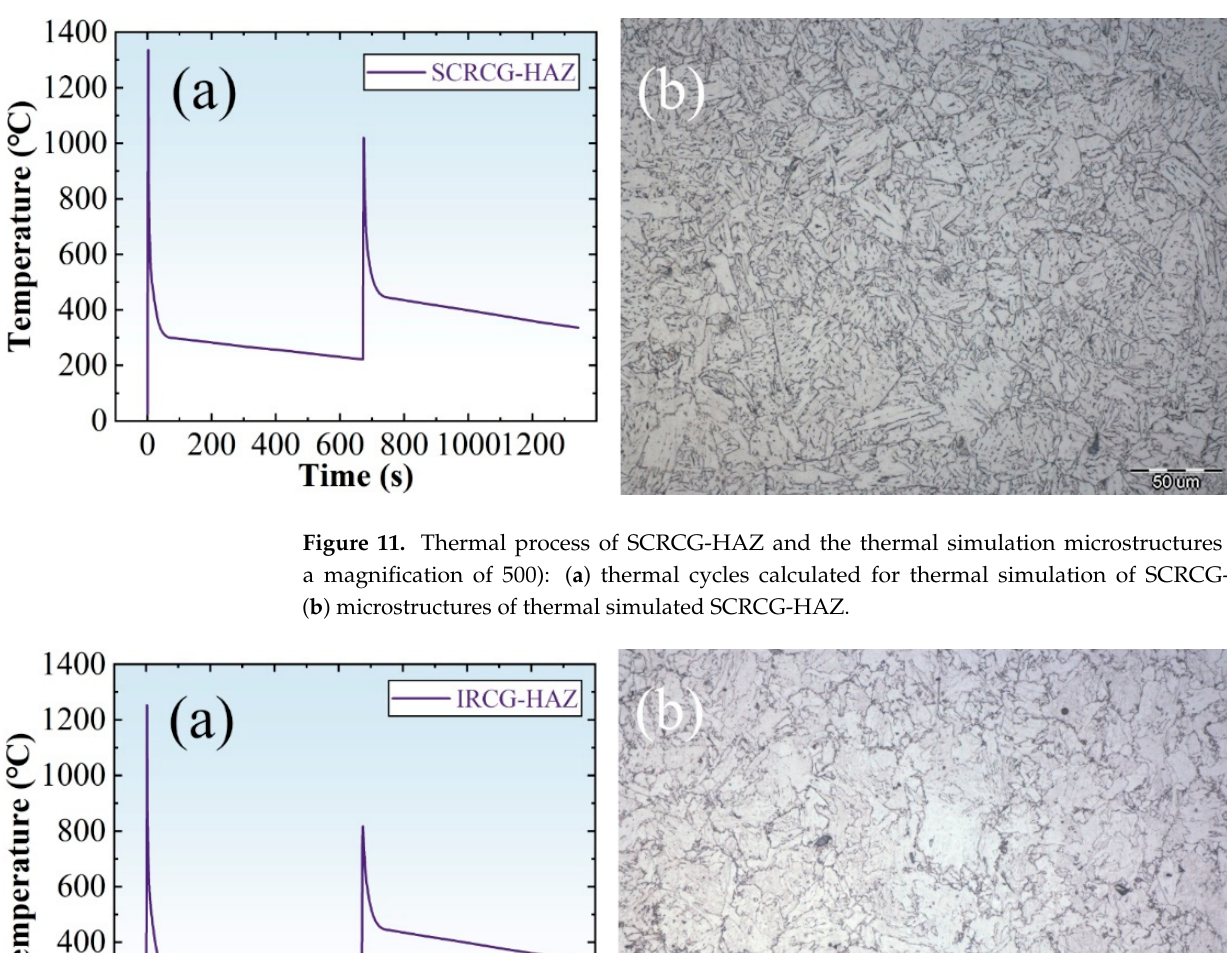
Figure 13. Thermal process of incomplete recrystallized UACG-HAZ and the thermal simulation microstructures (with a magnification of 500): ( a ) thermal cycles; ( b ) microstructures of the thermal simulation zone. For further discussion, CCT curves of the base metal and the typical cooling times in the last thermal cycle of each thermal simulation process were calculated and are given by Figure 14 and Table 10. The cooling time from 800 °C to 600 ℃ is marked as t 8/6 , the cooling time from 600 ℃ to 500 ℃ is marked as t 6/5 , the cooling time from 500 ℃ to Ms is marked as t 500/Ms , the peak temperature in the last austenitized process is marked as T p-end and the cooling time from the peak temperature to 800 ℃ is marked as t p/8 . According to Figure 14 and Table 10, it is indicated that all thermal simulated microstructures were bainite and ferrite. The temperature range of ferrite transformation is around 600 ℃ ~750 ℃ , and the ending temperature of bainite transformation is around 463 ℃ . The cooling time in the undercooled austenite decomposition procedure was significantly higher in zones twice austenitized, especially in the UACG-HAZ, compared to those with a single austenitized thermal cycle. The t p/8 showed the same pattern. A long t p/8 with a long t 8/6 and t 6/5 could lead to a larger prior austenite grain size because of the retention in the fast- growing temperature ranges and an increase in AF as well as the length of the laths be- cause of the relatively long staying time of t 500/Ms and t 6/5 in addition to a relatively larger grain size for the nucleation of intragranular ferrite. There was little difference in t 8/6 and t 6/5 between CG-HAZ2 and CG-HAZ3. Thus, more AF and longer laths could be found in CG-HAZ2, CG-HAZ3 and UACG-HAZ than in CG-HAZ1.